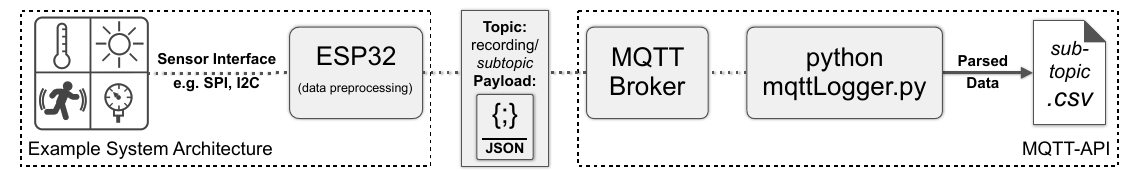
Figure 3. Example of extending the recording system by logging additional sensor data using the